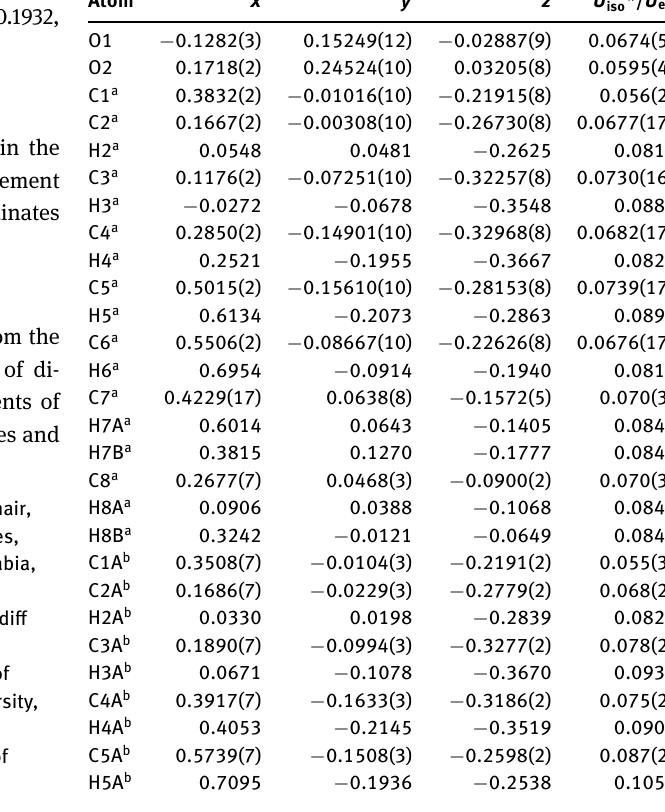
Table 2: Fractional atomic coordinates and isotropic or equivalent isotropic displacement parameters (Å 2